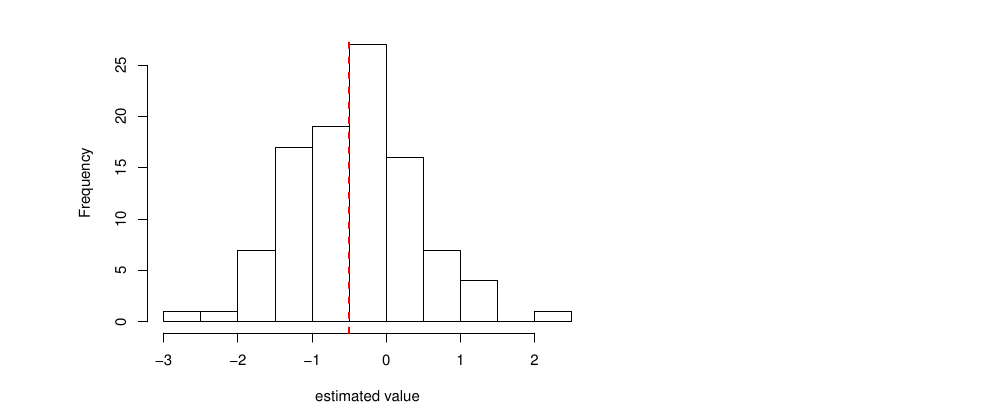
Figure 2. Histogram of the estimated values of β 1 in setting (ii). The red dotted line represents the true value.